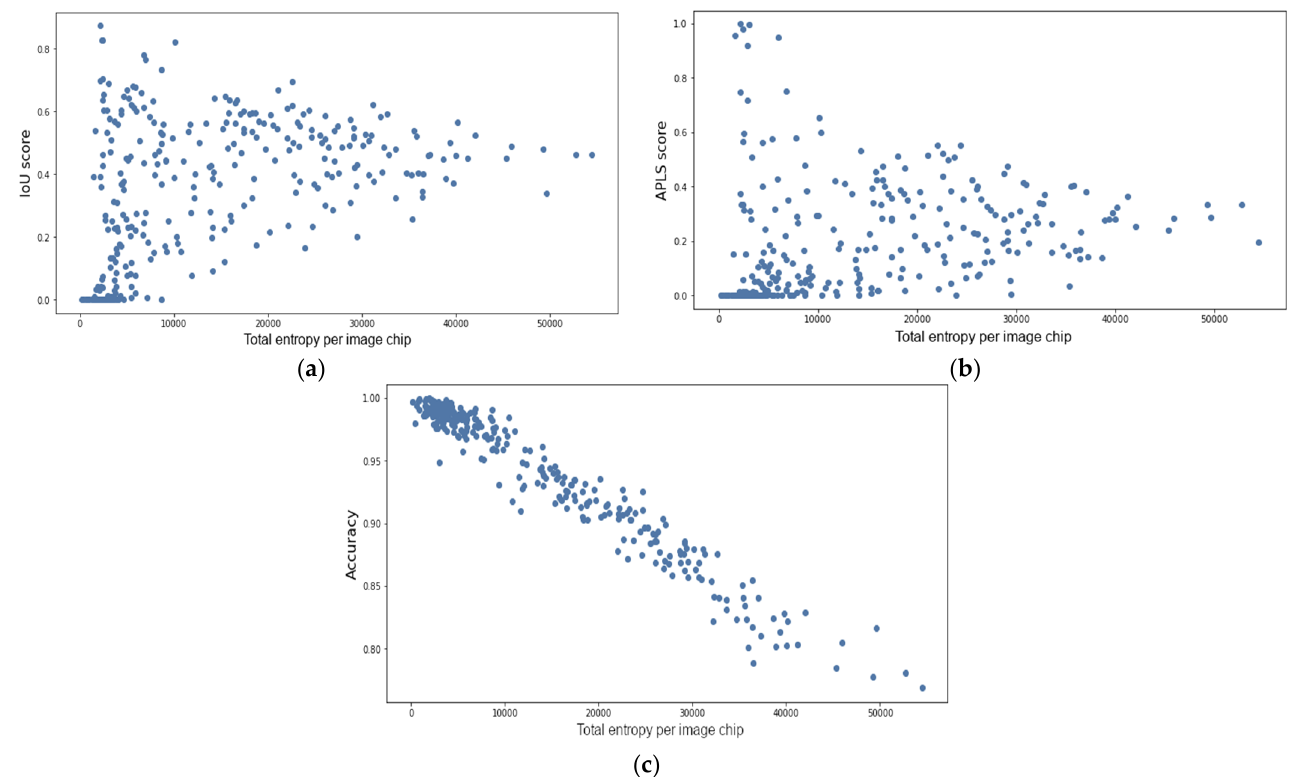
Figure 5. IoU ( a ) and APLS ( b ) do not correlate with entropy per image chip, despite the fact that entropy is well correlated with average pixel-wise segmentation accuracy per chip ( c ). IoU and APLS are much better measures of the segmentation performance of the